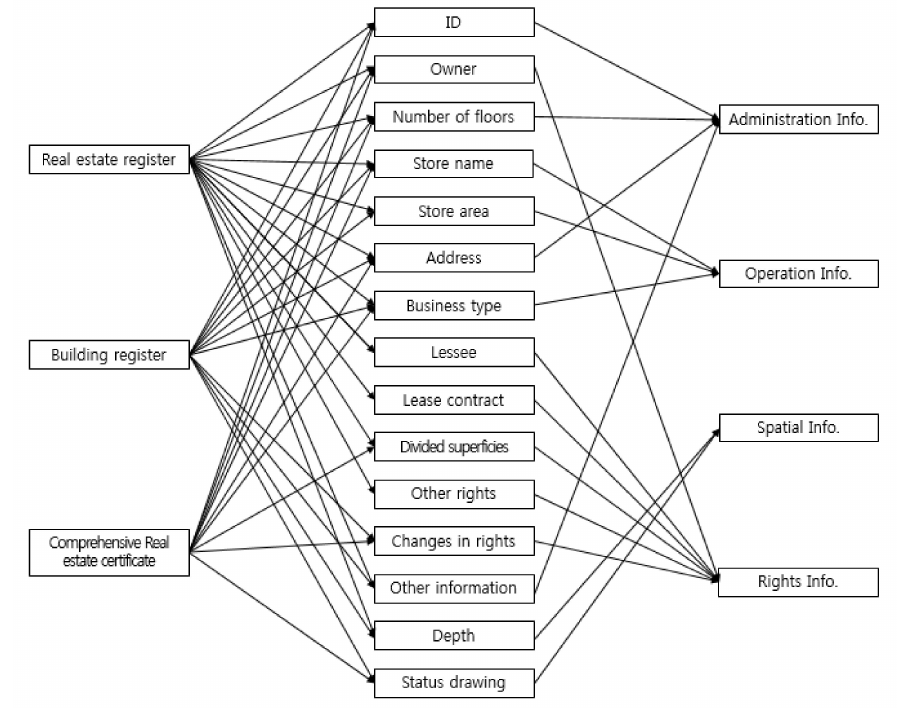
Figure 10. Rights status information generation for individual stores.